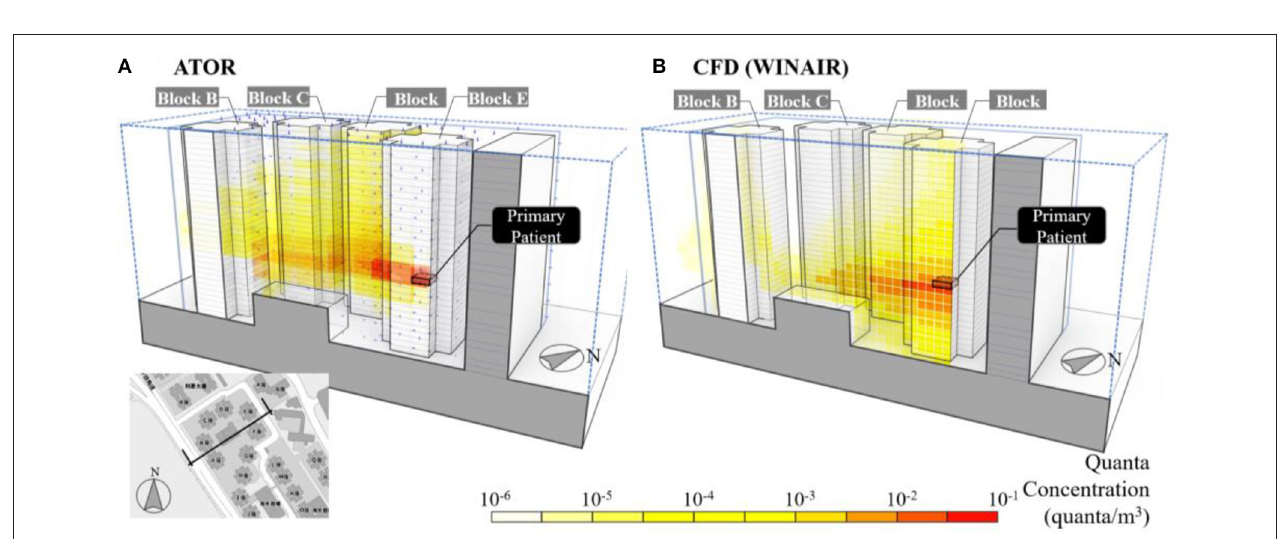
FIGURE 7 | Cross-sectional view of the predicted quanta concentration using (A) ATOR and (B) WINAIR in Amoy Gardens, Hong Kong during the SARS outbreak in 2003.